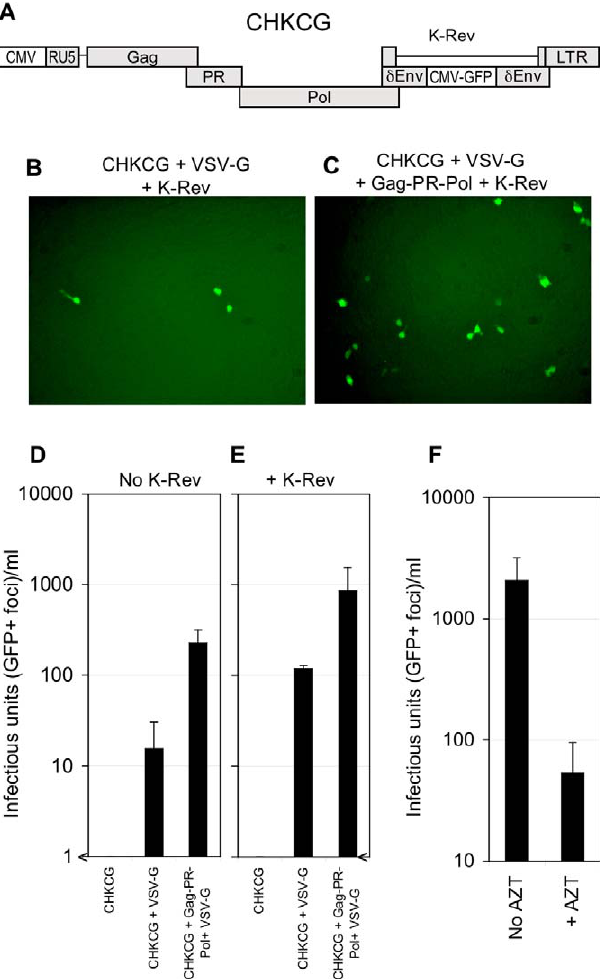
Figure 3. Generation of Single Cycle Infectious Virions Containing HERV- K CON Genomes and Gag-PR-Pol (A) Schematic representation of the HERV-K CON –based CHKCG genome. Changes to HERV-K CON are depicted in white boxes. The 5 9 LTR was modified to include the CMV promoter inserted in place of the U3 region. The Env ORF, which now contains CMV-GFP, is disrupted. (B and C) Photomicrographs of 293T cell monolayers after infection with CHKCG-carrying HERV-K CON (VSV-G) pseudotyped virions, which were generated following transfection of 293T cells with the indicated plasmid mixtures. (D and E) Infectious titers of HERV-K CON (VSV-G) pseudotyped virions generated following transfection with the indicated plasmid mixtures in the absence (D) or presence (E) of K-Rev/Rec and using 293T target cells. GFP-positive foci were enumerated visually and expressed as infectious units per milliliter of virion-containing supernatant. (F) Infectious titers of CHKCG containing HERV-K CON (VSV-G) using 293T target cells in the presence or absence of 50 l M AZT. All data are representative of at least three